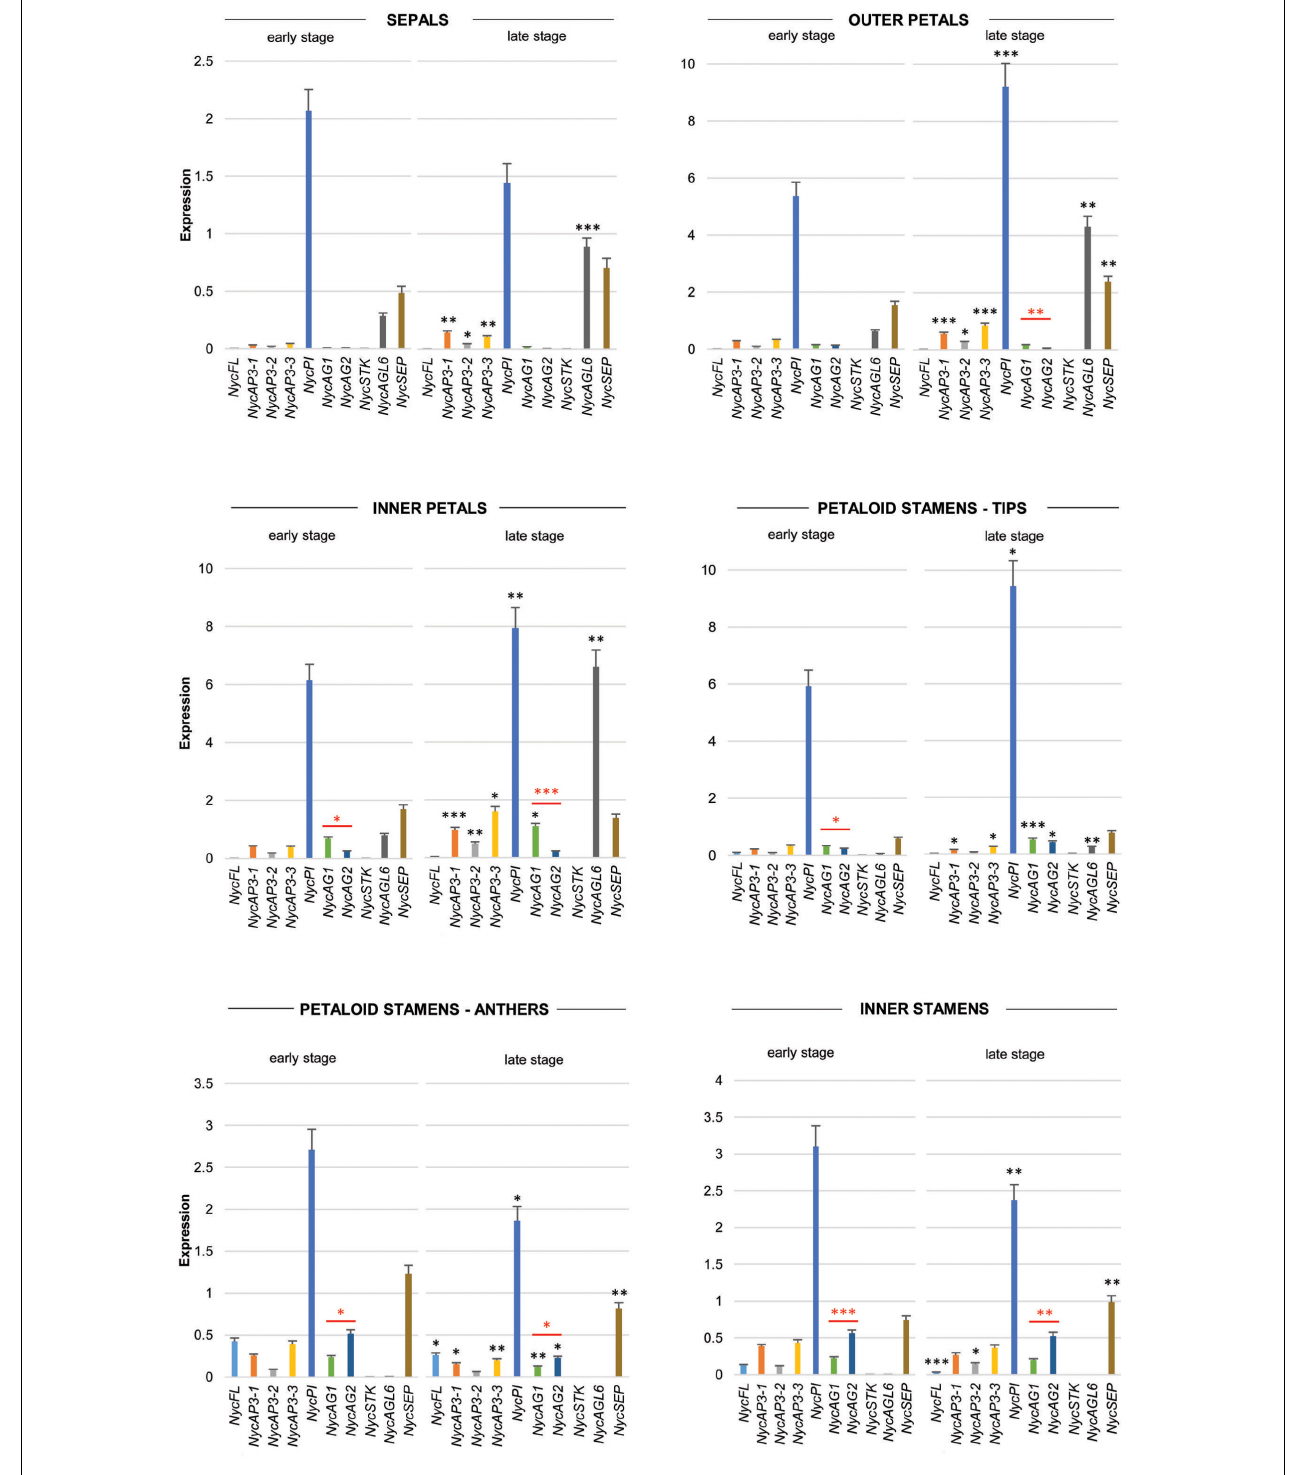
FIGURE 3 | Analysis of MADS-box gene expression during sepals, petals, and stamens development. Expression profiles of MADS-box genes in floral components (sepals, petals, petaloid stamens, and inner stamens) obtained from floral buds at two different stages of development (early and late stages, respectively) by qPCR experiments. Values in the graphs represent initial RNA quantities ± SEM. Black asterisks above an expression level indicate a significant difference between the two developmental stages, for that specific gene. Red asterisks indicate a significant difference of the expression levels of genes under the red bar ( ∗ p < 0.05; ∗∗ p < 0.01; ∗∗∗ p <